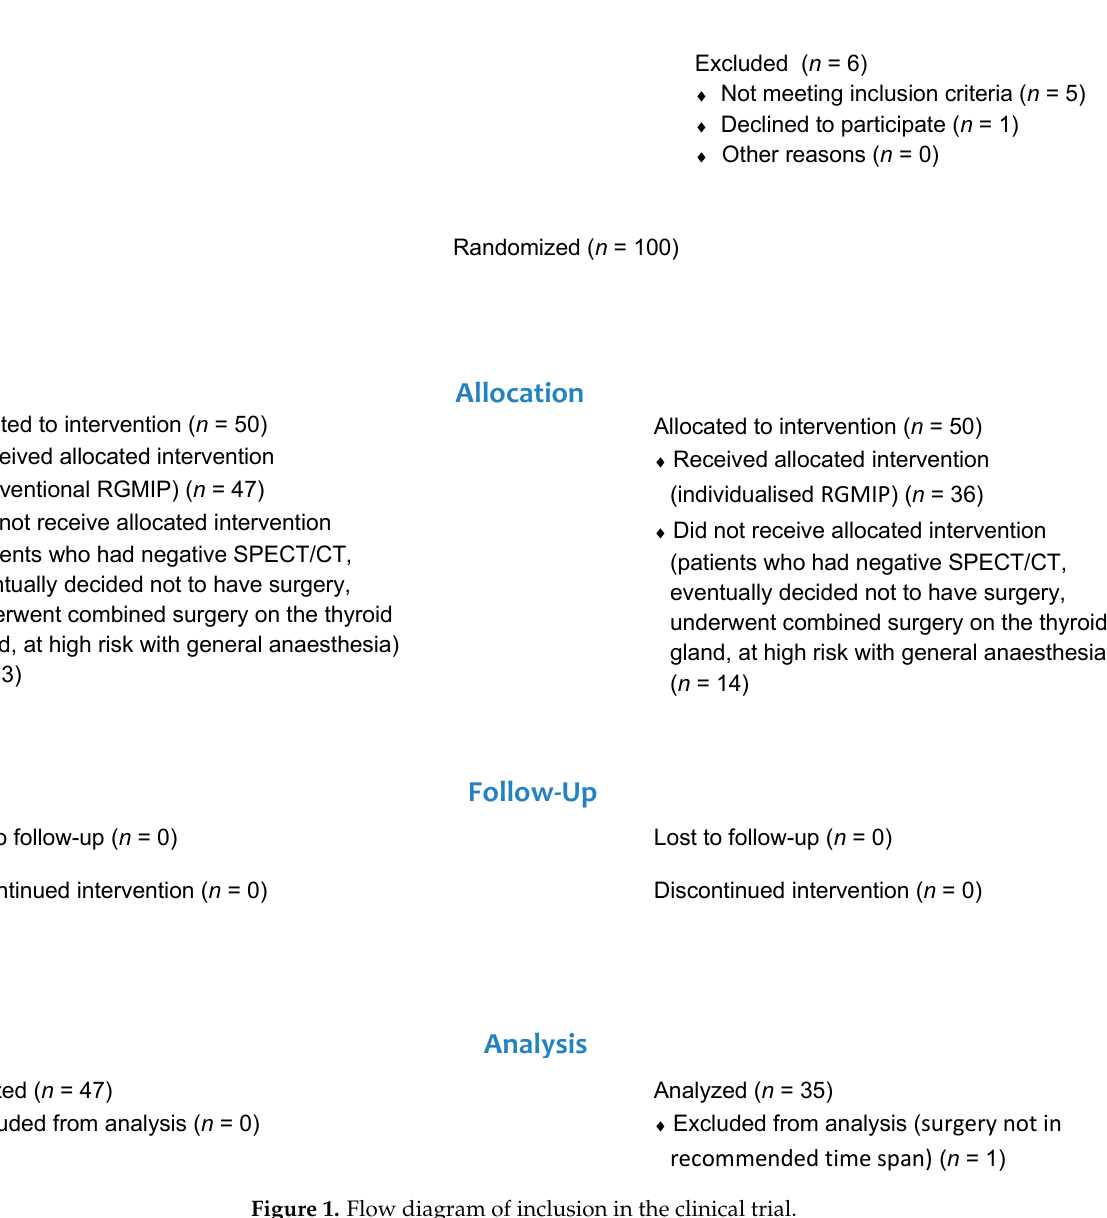
Figure 1. Flow diagram of inclusion in the clinical